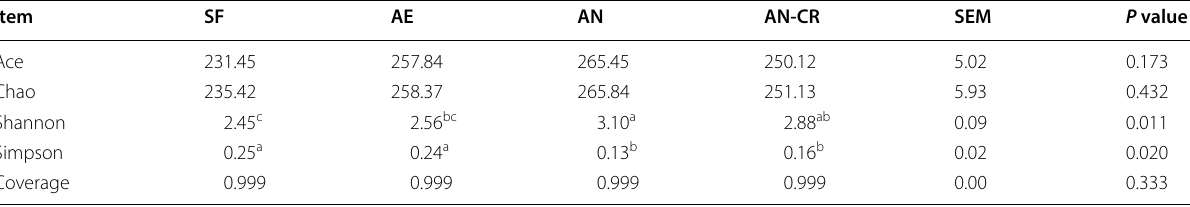
3. Means within the same row with different superscripts are significantly different from one =